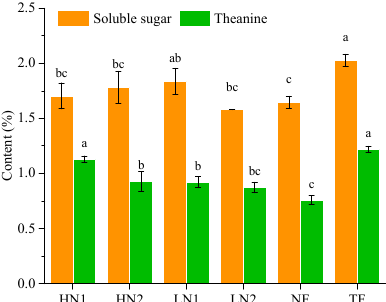
Figure 2. The contents of soluble sugar and theanine in tea shoots. The statistical approach used was LSD analysis. Every group contains 3 tea leaf samples. Different lower-case letters above bars indicate significant differences among treatments ( p < 0.05 ).